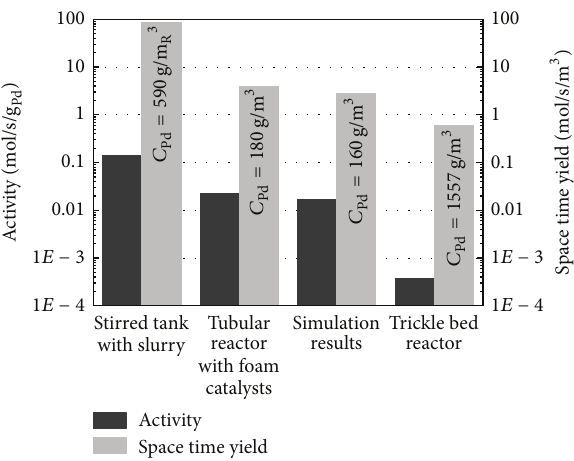
Figure 11: Comparison of the reactor performance of continuous tubular reactor with foam catalysts with conventional reactors; stirred tank with a fine slurry catalyst ( 𝑇 = 45.5 ∘ C, 𝑃 = 1.51 bar) Meille et al. [16]; tubular reactor with catalytically active foam packing in cocurrent upward flow (40 ∘ C, 10bar, 𝑉 𝐿 = 20 mLmin −1 ) Lali [33]; the simulation results of the present work (40 ∘ C, 10 bar, = 20 mLmin −1 ) Lali [33]; trickle bed reactor (40 ∘ C, 10bar, 𝑉 𝑉 𝐿 25 mLmin −1 ) Schubert [34].